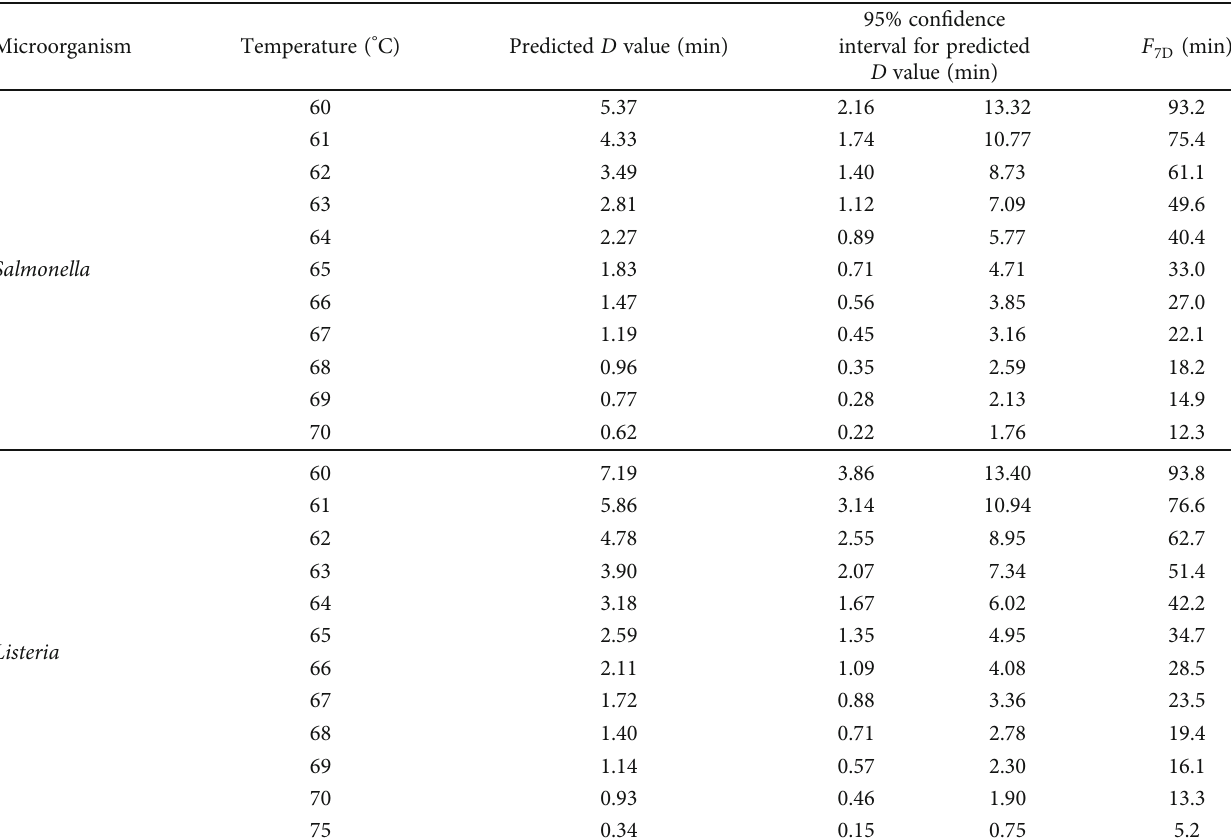
Table 4: Predicted D values and 95% con fi dence intervals for Salmonella enterica ( z = 10 : 7 ° C ) and Listeria monocytogenes ( z = 11 : 3 ° C ) at di ff erent temperatures.